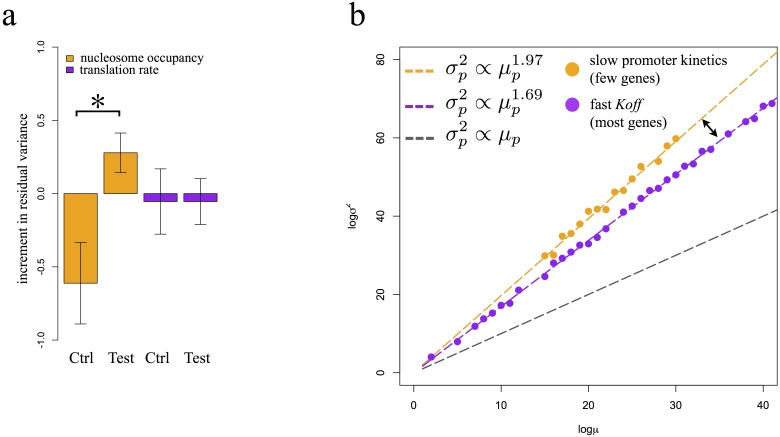
Modulating promoter kinetics changes protein mean-variance scaling.a) Increment in residual variance from glucose to ethanol in genes that show increased occupancy in ethanol (orange set: test) and genes with unaltered occupancy (orange set: control) compared to the same genes ranked by high (purple set: test) or low (purple set: test) increase in translation rate (purple set) (* indicates p<0.05, t-test). b) Diagram connecting the power-law exponent to promoter kinetics: most genes in S. cerevisiae exhibit promoter kinetics characterized by fast inactivation rate (purple dots) and display protein mean-variance scaling dictated by a power-law with 1.69 exponent (purple line). A small set of genes (orange dots) exhibit slow promoter kinetics and consequently present protein mean-variance scaling dictated by a quadratic scaling (orange line).